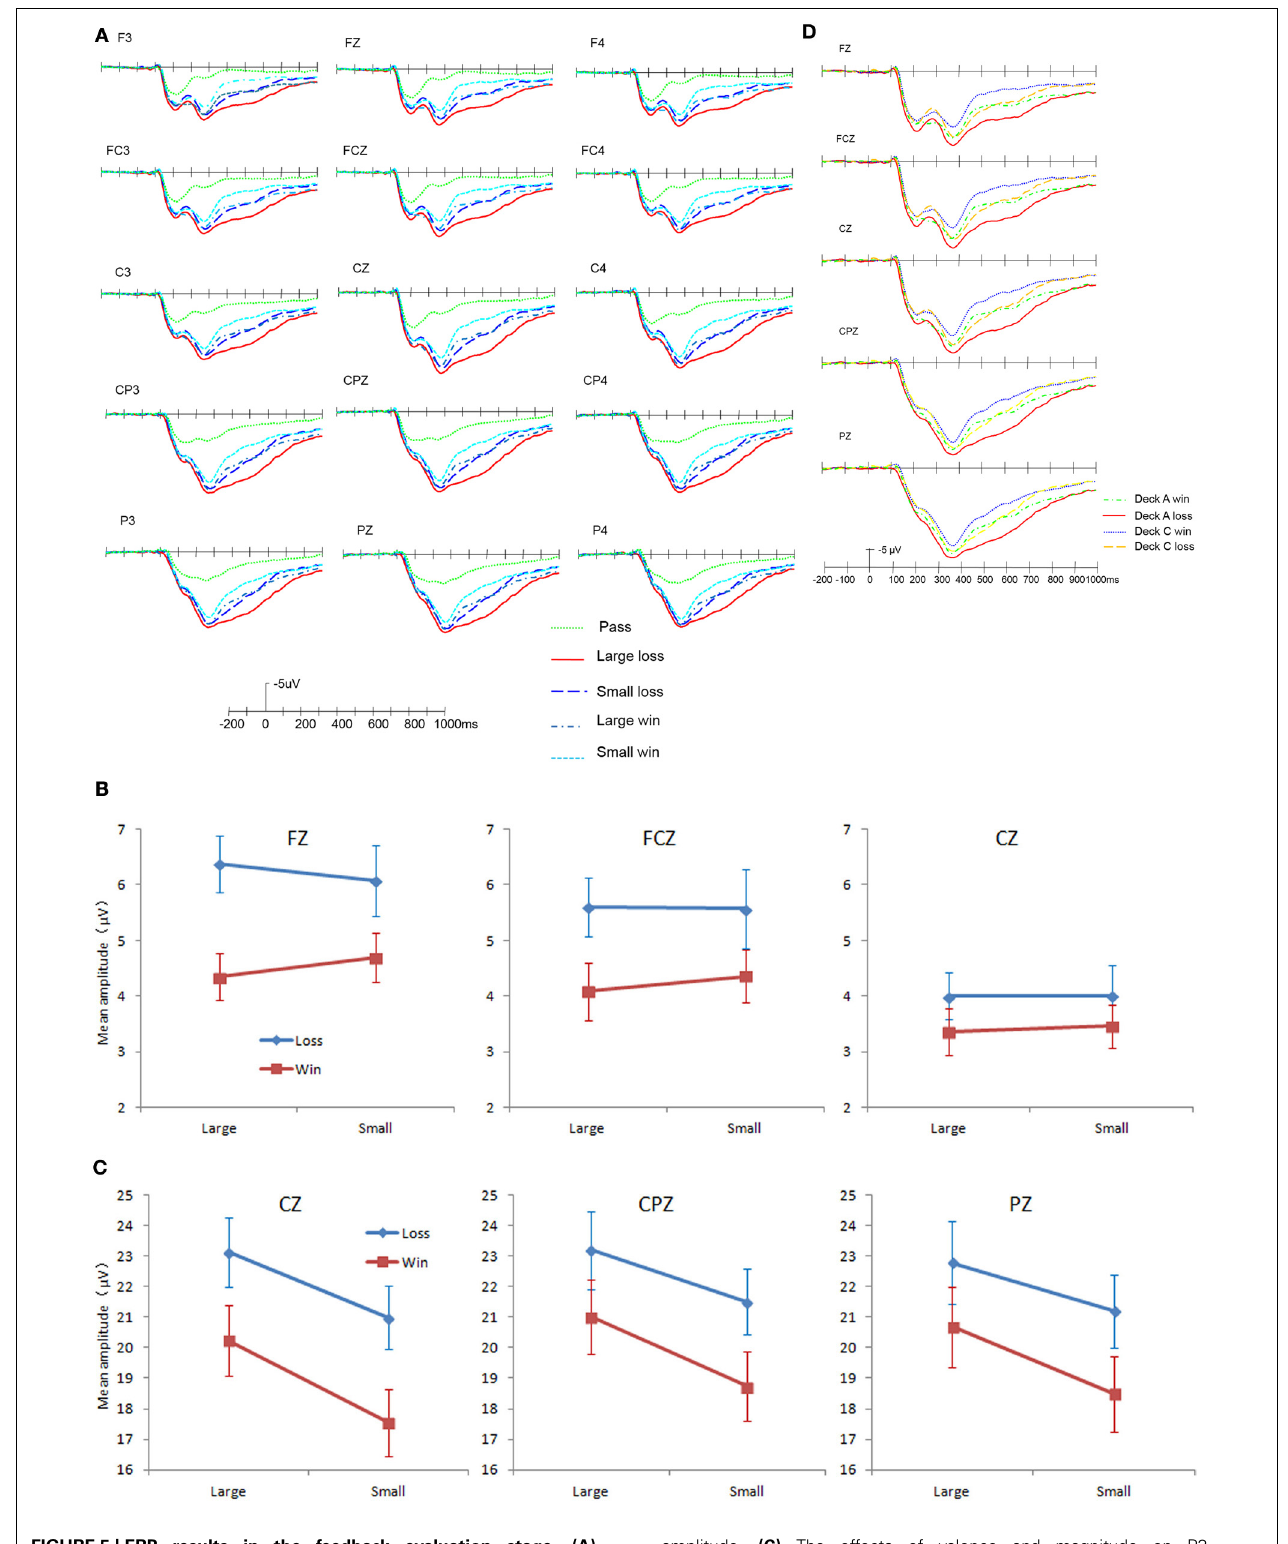
FIGURE 5 | ERP results in the feedback evaluation stage. (A) Grand average ERP for different valences and magnitudes in feedback. (B) The effects of valence and magnitude on FRN